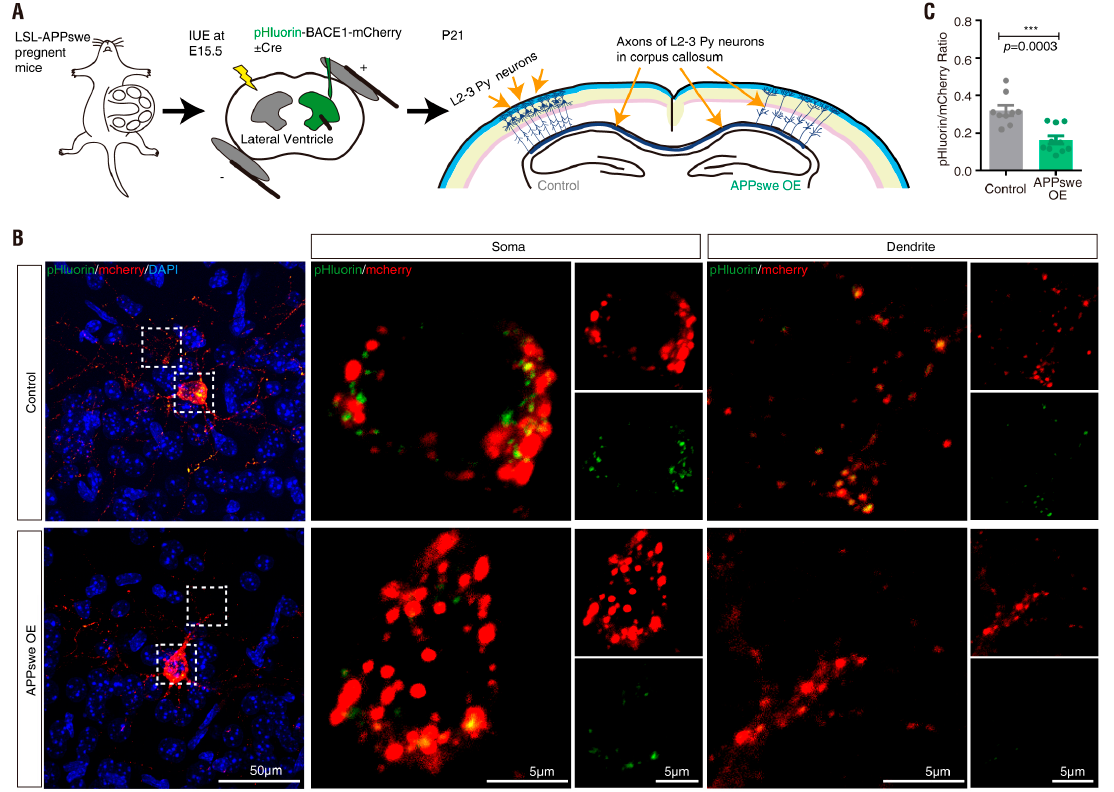
Figure 11. APPswe regulation of pHluorin ‐ BACE1 ‐ mCherry and BACE1 activity in vivo ( A ) Schematics of in utero electroporation experimental procedures. LSL ‐ APPswe embryos were in utero electroporated with plasmids of pHluorin ‐ BACE1 ‐ mCherry and BFP (control) or pHluorin ‐ BACE1 ‐ mCherry and Cre (APPswe OE) at E15.5. The neocortical brain sections were collected at P21. ( B ) Representative Z-stack projection images from neocortical brain sections was shown. Scale bar, 50 µ m / 5 µ m. ( C ) Quantification analysis of the pHluorin / mCherry ratio from ( B ). Data was shown as mean ± SEM ( n > 30 neurons from three independent experiments). Significance was calculated with Student’s t -test; *** p < 0.001.